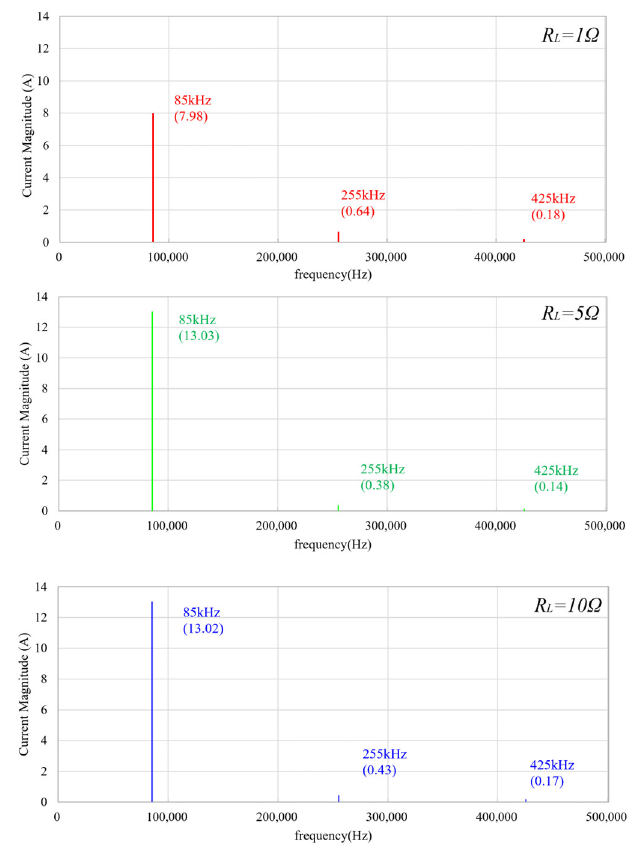
Figure 5. Simulation results of I p harmonics under different load resistances.